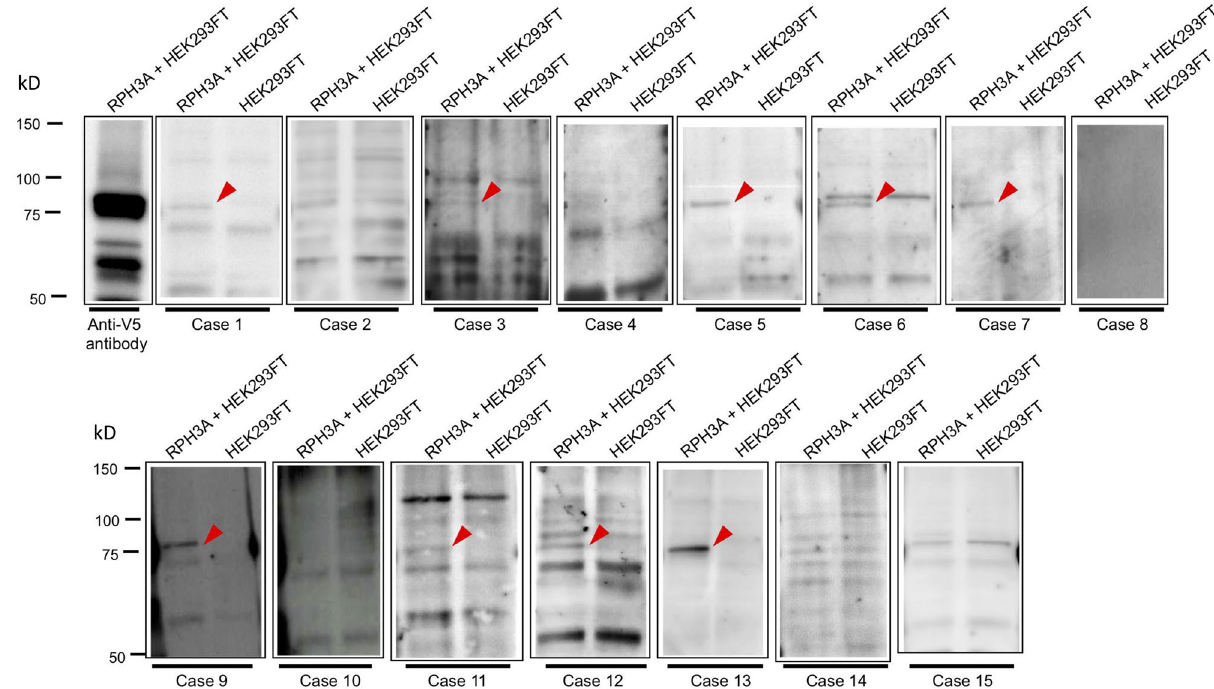
Figure 4. Detection of anti-rabphilin-3A antibodies by Western blotting. Recombinant full-length human rabphilin-3A expressed in HEK293FT cells (RPH3A + HEK293FT, left lane in each case) or negative control (HEK293FT, right lane in each case) were probed with serum from Case 1 to 15. The arrowhead indicates the presence of anti-rabphilin-3A antibodies in serum. Recombinant full-length human rabphilin-3A expressed in HEK293FT cells was also probed with an anti-V5 antibody as positive control (Anti-V5 antibody) in the first lane from the left. Cropped Western blots were from different gels and were made explicit using delineation with dividing